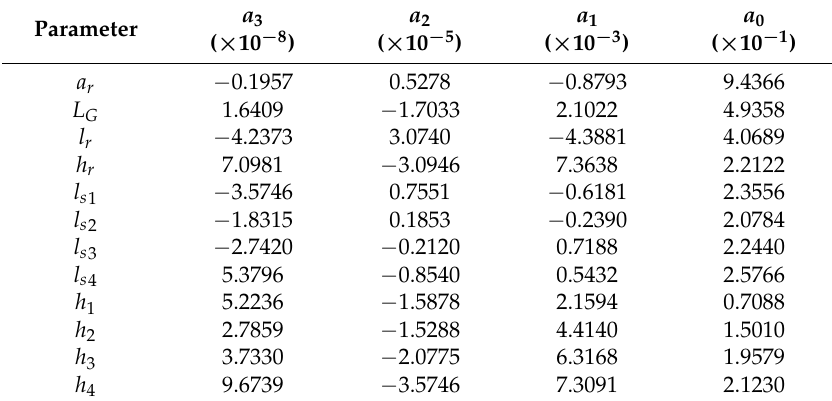
Table 1. Coefficients for the fitting equations of the DPS’s parameters. Widths and heights are normalized to the standard waveguide dimensions a and b respectively; lengths are normalized to λ g , where λ g is the empty waveguide wavelength at the center frequency.